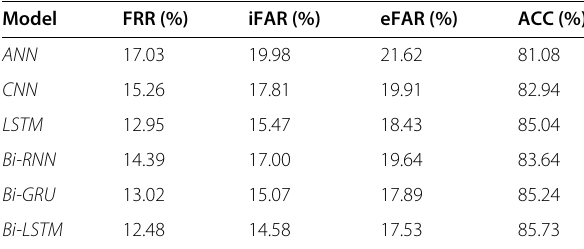
Table 5 The effects of different neural networks on classifiers performance